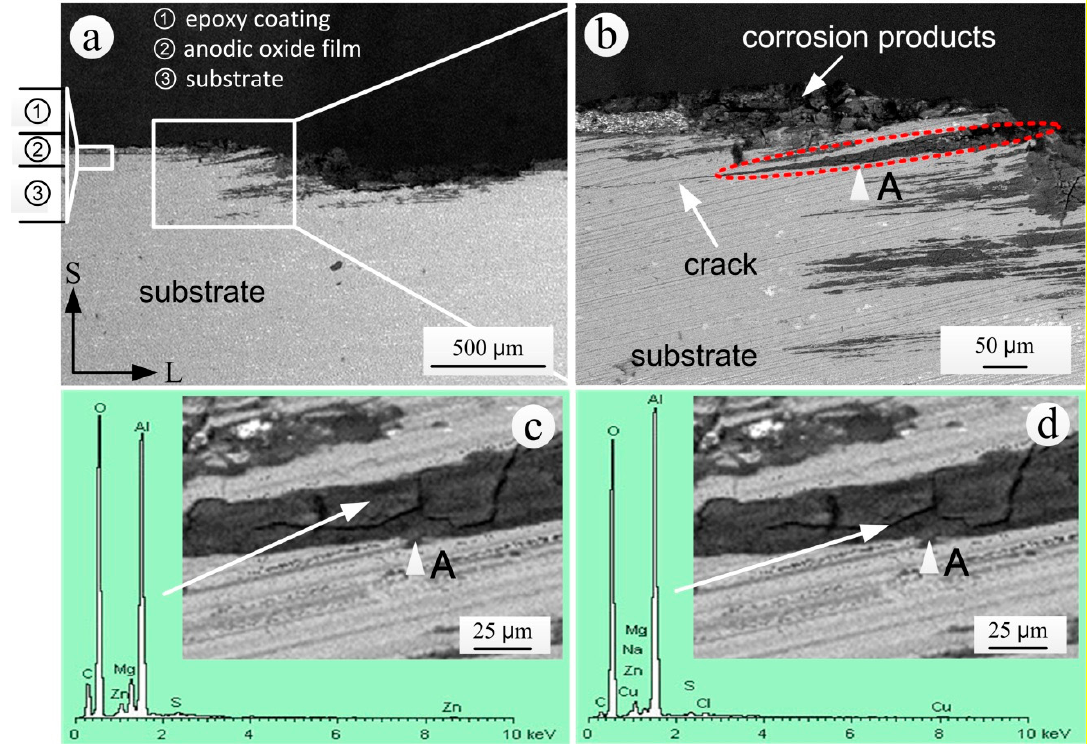
Figure 13. S-L sectional analysis in the junction area between the corroded and un-corroded substrate of the specimen exposed for 20 years: ( a ) SEM morphology; ( b ) local enlarged SEM morphology; ( c ) EDS spectrum in the lump area of the corrosion products; ( d ) EDS spectrum in the cracking area of the corrosion products.